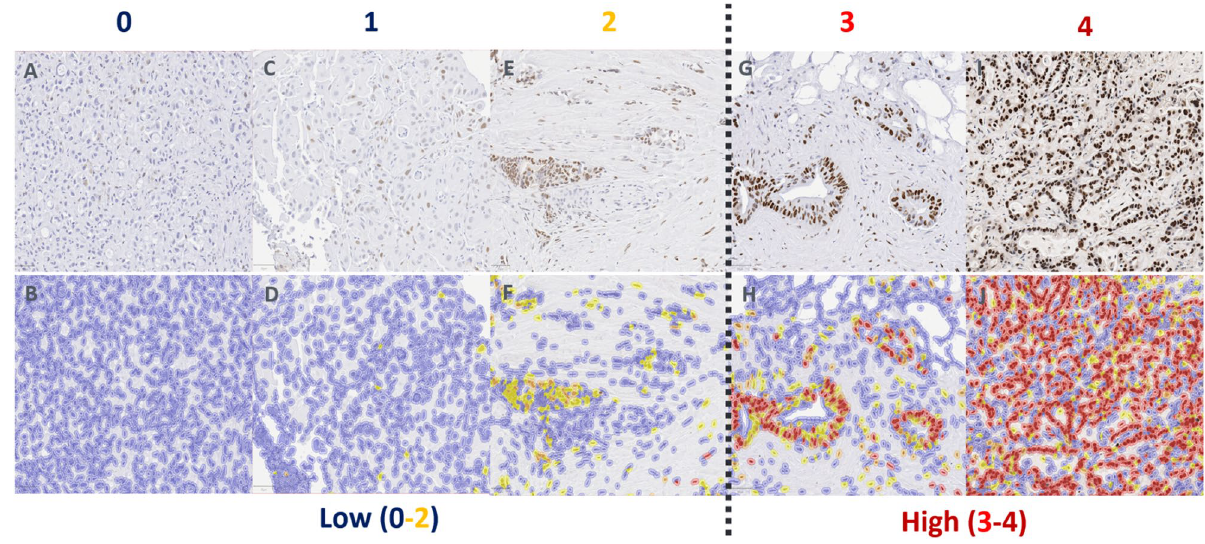
Figure 2. GATA6 IHC expression levels. No or weak GATA6 IHC expression (scores 0–1) without digital assistance ( A , C ) and with digital assistance ( B , D ) showing tumor as predominantly blue. Moderate GATA6 IHC expression (score 2) without digital assistance ( E ) and with digital assistance ( F ) showing tumor as predominantly yellow. ( D ) Strong GATA6 IHC expression (score 3) without digital assistance ( G ) and with digital assistance ( H ) showing tumor as predominantly red (≥ 50% of tumor cells). ( E ) Very strong GATA6 IHC expression (score 4) without digital assistance ( I ) and with digital assistance ( J ) showing tumor as nearly all red (≥ 90% of tumor cells). GATA6 IHC expression levels were regrouped into low (0–2) and high (3–4) groups to assess for an association with clinical outcome.